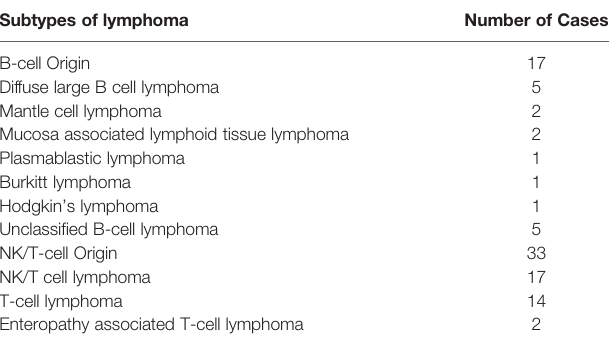
TABLE 3 | Subtypes of Ulcerative Primary intestinal